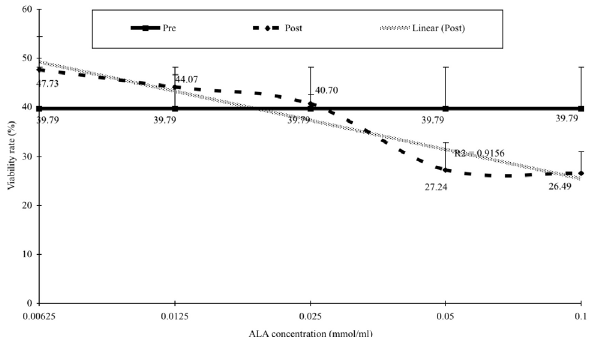
Figure 2 - Dose response curve of ALA against sperm vitality. Sperm vitality was assessed using light microscope with Mtrack J Imaging System on the Weber sterility chamber. Mann-Whitney t-test was used to determine the differences between baseline (pre) and after one-hour incubation (post). There is no significant differences between pre and post treatment (P>0.05). r 2 = 0.9156 N=31